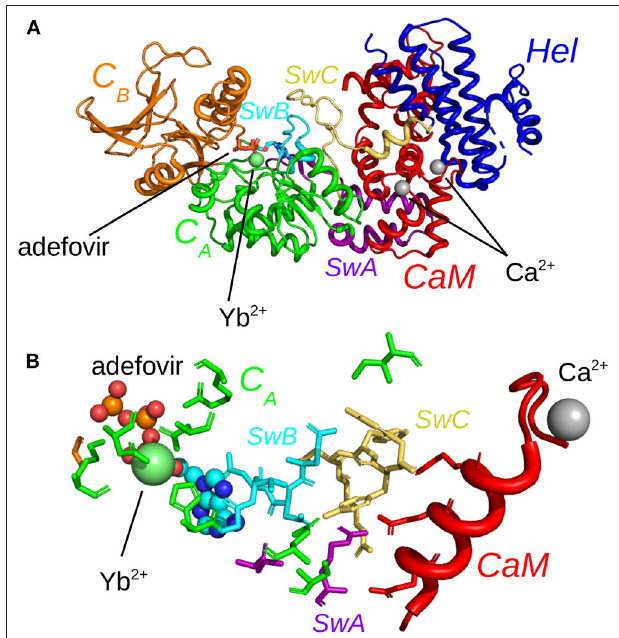
FIGURE 1 | (A) X-ray crystallographic structure (PDB entry: 1PK0) of the complex EF/CaM with the ions Ca 2 + colored in gray and the ion Yb 2 + colored in lime. The ligand adefovir is drawn in ball-and-sticks, the regions C A (residues 292-349 and 490-622), C B (residues 350-489) and helical (residues 660-800, labeled “Hel” on the figure). of EF are colored in green, orange and blue and CaM is colored in red. The switches A (residues 502-551), B (residues 578-591), and C (residues 630-659), labeled SwA, SwB, and SwC, are colored in purple, cyan, and yellow. The helix V of CaM is colored in salmon. (B) Network of residues in the X-ray crystallographic structure (PDB entry: 1PK0) of the complex EF/CaM connecting residues of the catalytic site to residues of the α helix V of CaM. The ligand adefovir is drawn in spheres. The helix V is drawn in carton. The residues of CaM, region C A and of switches A, B, and C are in the same colors than in (A)